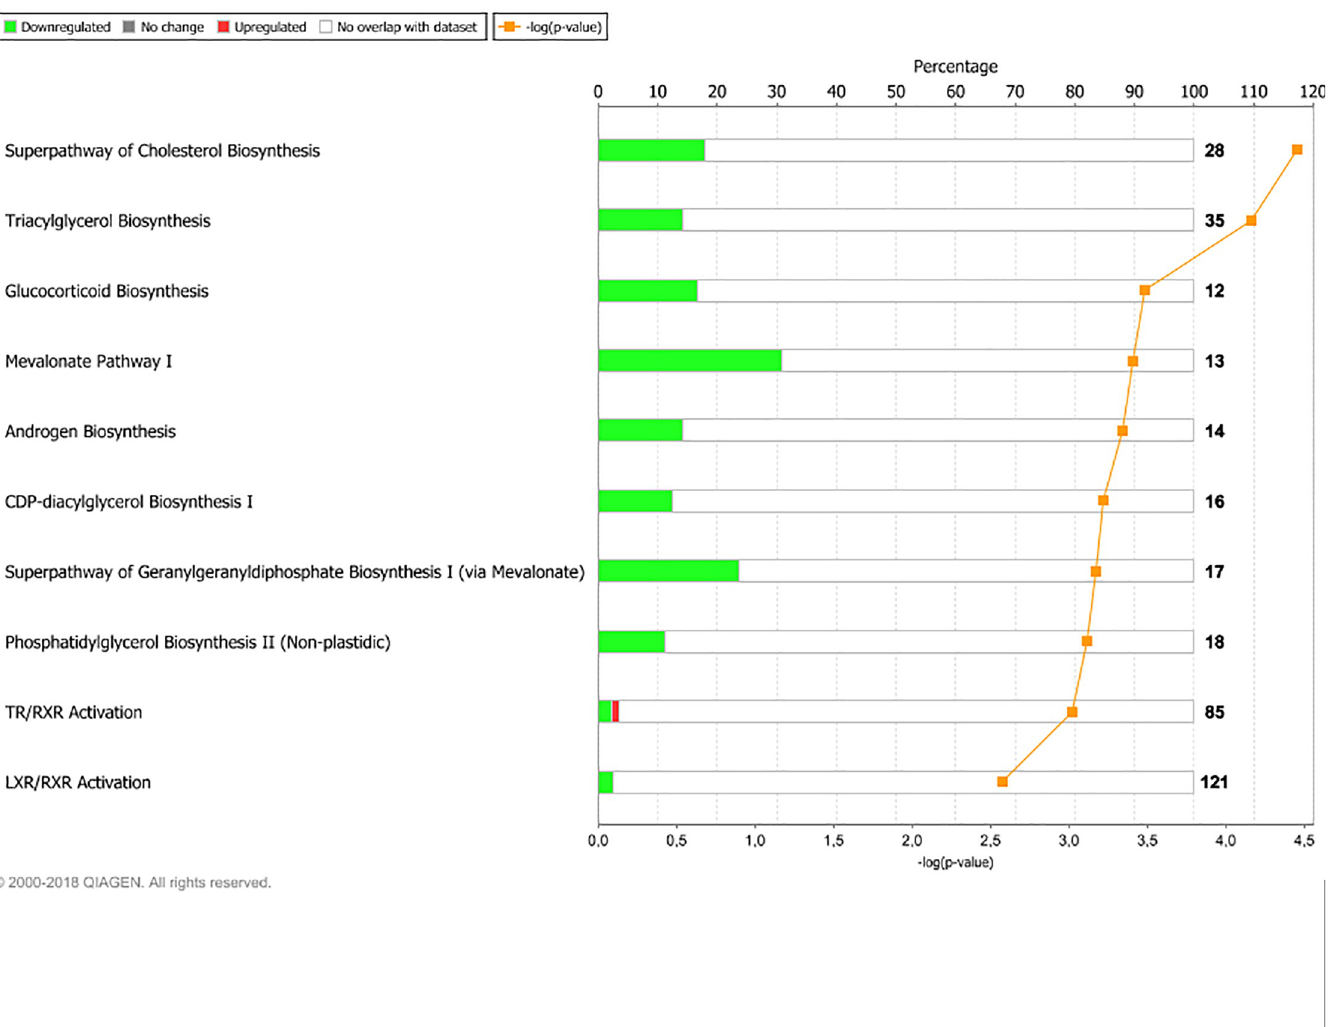
Fig 2. Main pathways affected by differently expressed genes between High-Protein, High-Energy- and High-Protein, Low- Energy heifers at month seven of pregnancy. Main affected pathways between heifers fed High-Protein, High-Energy (HPHE) or High-Protein, Low-Energy (HPLE) diets until pregnancy when comparing them at month 7 of gestation. Red bars indicate percent upregulated, and green bars indicate percent downregulated genes pertaining to the pathway in HPHE versus HPLE heifers. Number to the right of bars display total number of genes pertaining to each pathway. Orange squares indicate the negative logarithm of p- value of observation (-log p-value = 1.3 equals p-value = 0.05). (Reprinted from IPA under a CC BY license, with permission from Qiagen Bioinformatics, original copyright